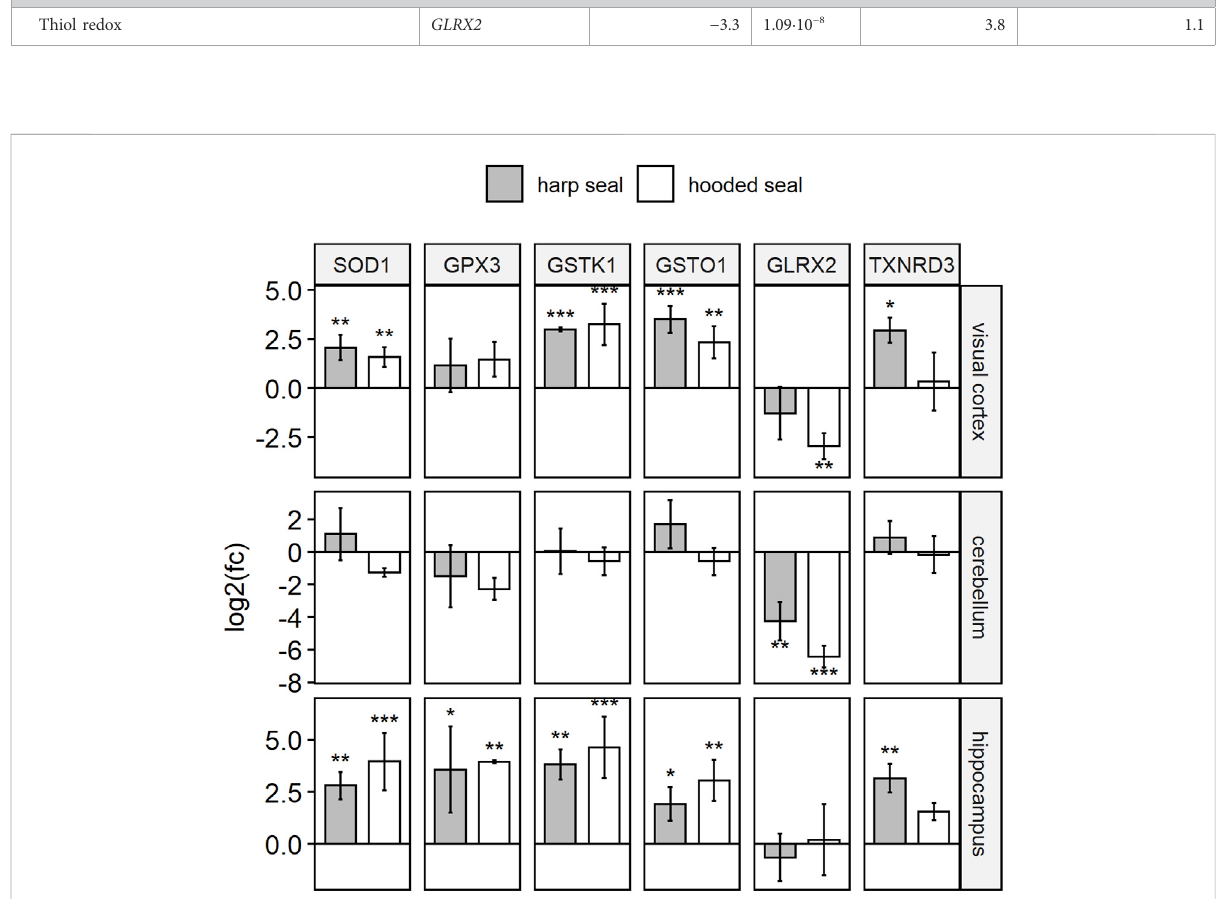
FIGURE 1 Antioxidant gene expression of hooded seals and harp seals, when compared to mice, as determined using qPCR. Relative gene expression is presented in log2 fold changes [log2 (fc)], whereby positive/negative values represent higher/lower expression in seals as compared to mice. Signi fi cance is expressed by asterisks ( p ≤ 0.05 (*), p ≤ 0.01 (**), p ≤ 0.01